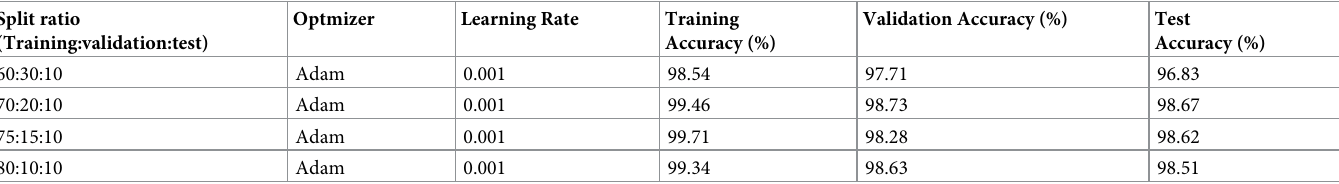
Table 22. Performance of proposed model on the dataset before augmentation with various splitting ratios. Split ratio Optmizer Learning Rate Training (Training:validation:test)